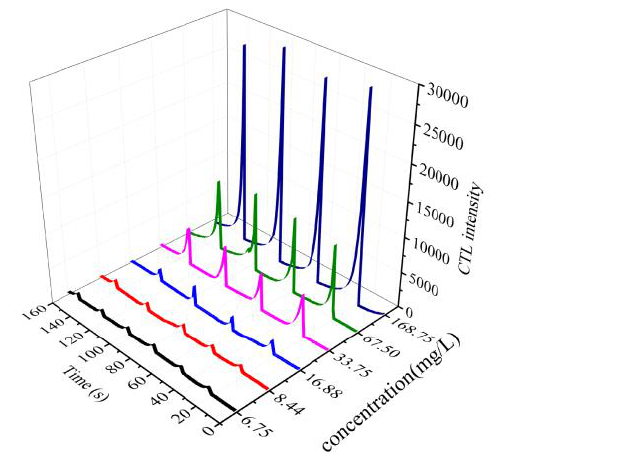
2 ; ( b ) the calibration curve for CS 2